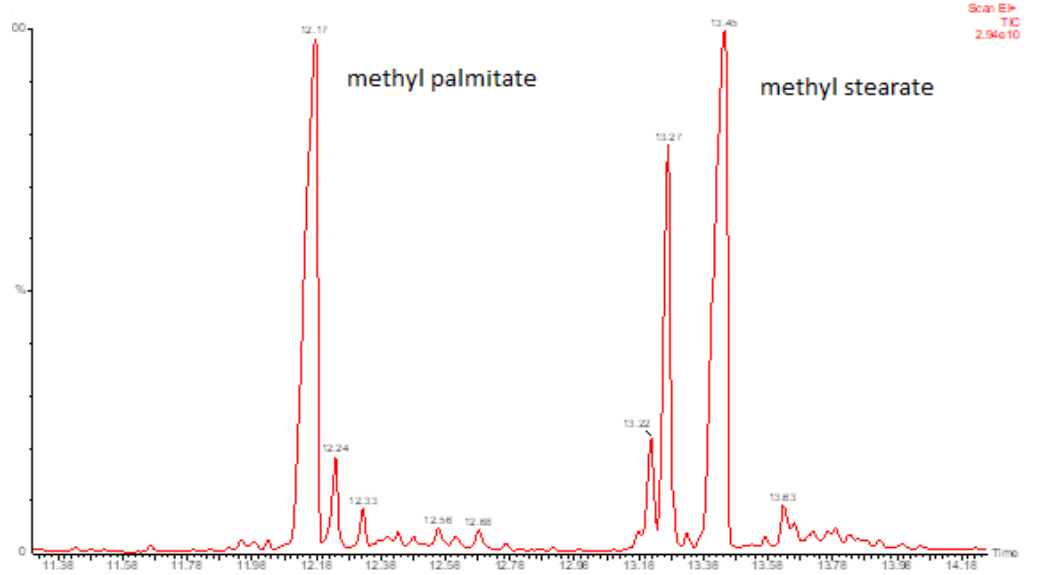
Figure 4. A portion of the chromatogram with dominant peaks of FAMEs. The remaining peaks are FAME isomers.